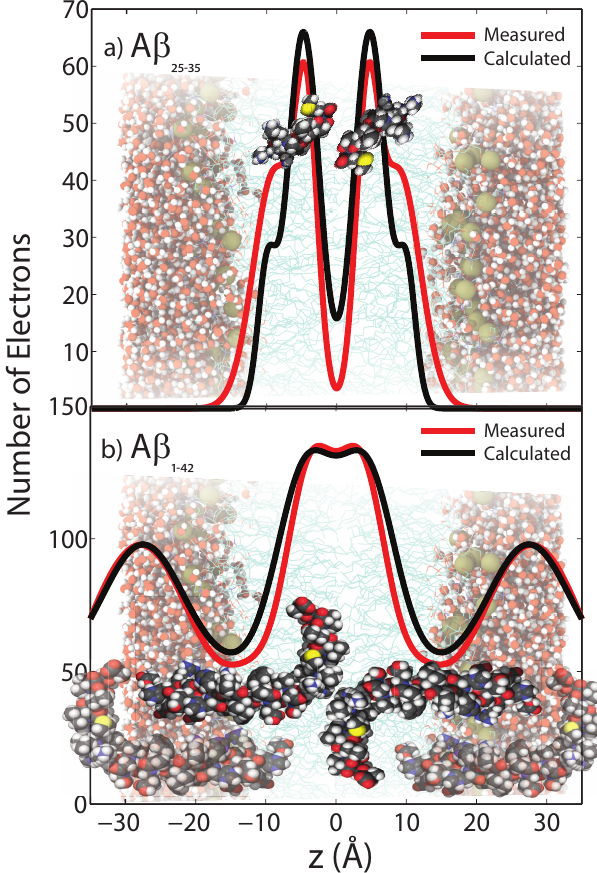
Figure 5. Measured and calculated electron distributionof the membrane-embedded A β 25 − 35 ( a ) and A β 1 − 42 ( b ) peptides and their position in the membrane. Good agreement between calculations and experiments was obtained for a position of A β 25 − 35 in the hydrocarbon membrane core. The peptide takes a slightly tilted orientation, in agreement with computer simulations. The full length A β 1 − 42 peptide was also found to embed in anionic lipid membranes. These results exclude a membrane-spanning β -sheet structure for A β monomers, as was reported from Molecular Dynamics simulations [51,54,55]. (Adapted from [49], copyright PLoS ONE,